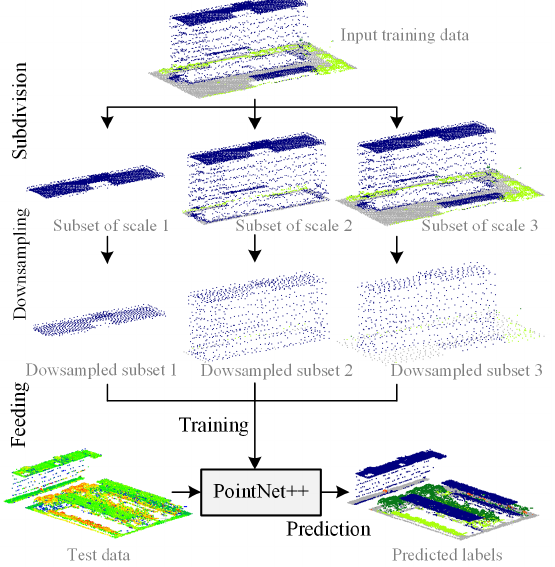
Figure 13. The workflow of Hierarchical Data Augmented (HDA)-PointNet++ with a hierarchical data augmentation